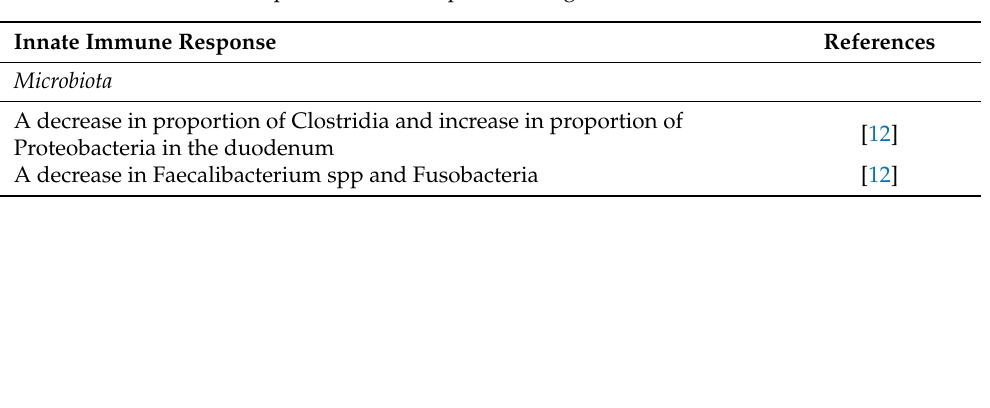
Figure 1. Cross-talk in the immune responses and their possible role in the pathogenesis of chronic inflammatory enteropathy (CIE) in dogs. ( A ) In CIE, barrier integrity breakdown leads to patho- logical inflammation and loss of immunological tolerance. A decrease in bacteria forming part of the physiologic microbiota such as Faecalibacterium spp. and Fusobacterium phyla has been identified. ( B ) Goblet-cell-derived peptide and glycoprotein expression from enterocytes is up- or down-regulated. ( C ) During intestinal inflammation, IL-8 contributes to neutrophil recruitment and secretion of IL-1 α , IL-1 β , and TNF- α . ( D ) Phagocytic cells, including antigen-presenting cells (APCs) such as dendritic cells (DCs) and macrophages phagocyte microorganisms and differentiate to a pro-inflammatory phenotype, secreting IL-12, TNF- α , IL-1 β , and IL-6. Additionally, ( E ) the number and degranulation of eosinophils and ( F ) the number and granules of mast cells are in- creased. ( G ) When the barrier is disrupted, mucosal permeability facilitates microbiota influx and phagocytosis. The microbiota influx also promotes microbiota–mast-cell interaction and releasing of immunomodulatory molecules. ( H ) APCs phagocyte pathogens and migrate to mesenteric lymph nodes to present antigens and activate different subpopulations of CD4+ T lymphocytes. ( I ) Th1 is stimulated by IL-12 released by APC and secretes mainly IL-2, IL-12, INF- γ , and TNF- α , while ( J ) Th2 is stimulated by IL-4 released by APC to produce IL-6, IL-4, IL-5, IL-9, and IL-13. ( K ) There is an increase in B lymphocytes and in IgG, IgG3, and IgG4 levels but a decrease in IgA in the intestinal mucosa. ( L ) When activated, APCs secrete IL-6 and TGF- β , and a Th17 subpopulation is activated. This population secretes IL-17A, IL-17F, and IL-22, which participate in neutrophil recruitment. Finally, ( M ) Treg subpopulations secrete IL-10 and TGF- β , contributing to control of the immune response. However, in dogs, a Th predominant immune profile for CIE has not been completely determined. In addition, ( N ) an increase in intestinal intraepithelial lymphocytes has been identified in dogs with CIE. Table 1. The innate and adaptive immune response in dogs with